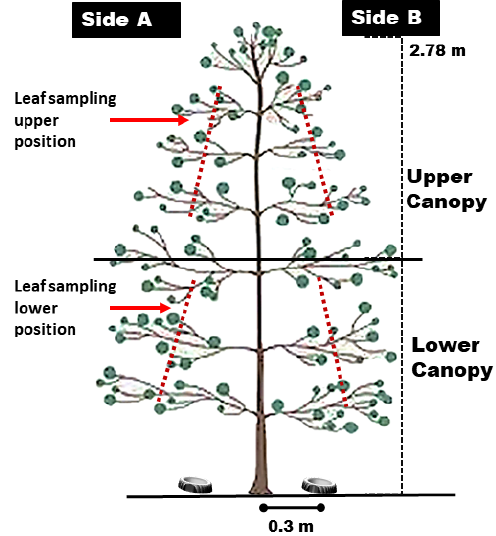
Figure 4. Heights used for sampling the coffee trees (Side A: left, Side B: right). Figure 4 . Heights used for sampling the coffee trees (Side A: left, Side B: right).